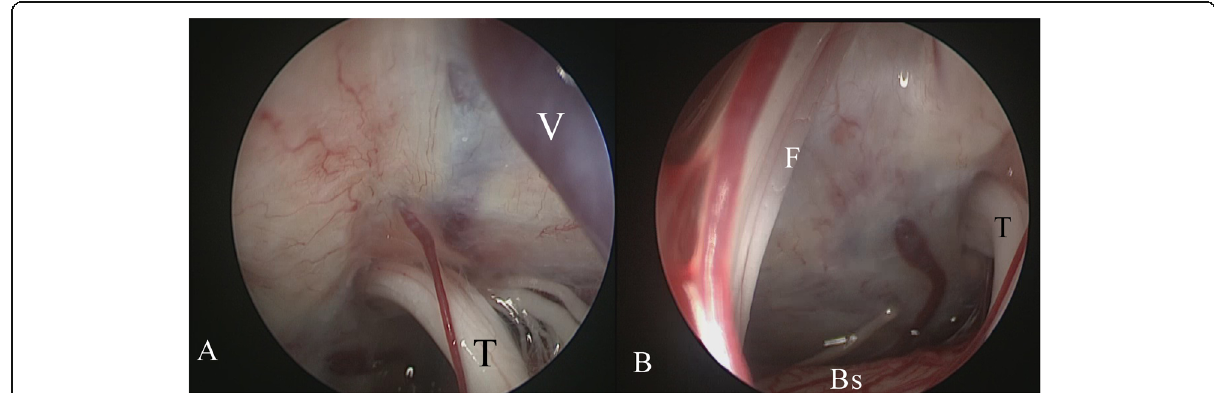
Fig. 5 ( a and b ) Endoscopic view showing the trigeminal nerve (left side). T., Trigeminal nerve. V., Vein. Bs., brain stem. F., Facial